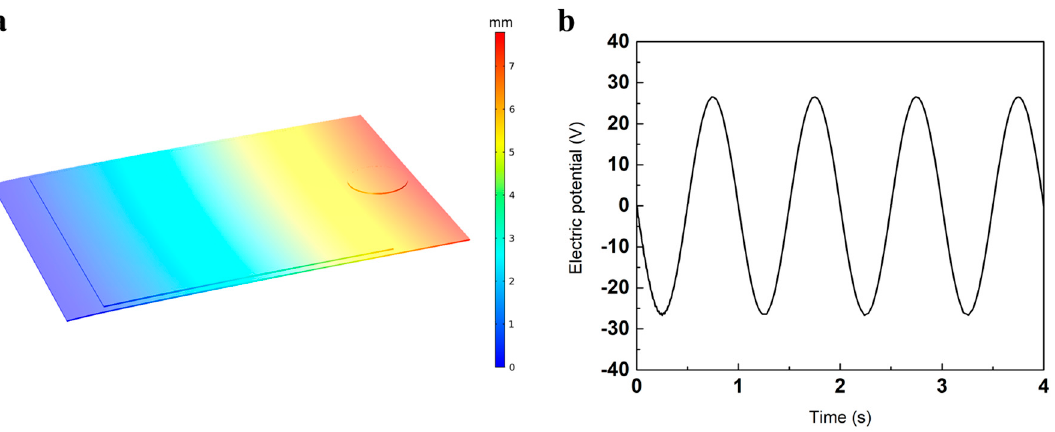
Figure 4. ( a ) Total displacement of the piezoelectric device in millimeters, ( b ) Open-circuit voltage across the piezoelectric device.